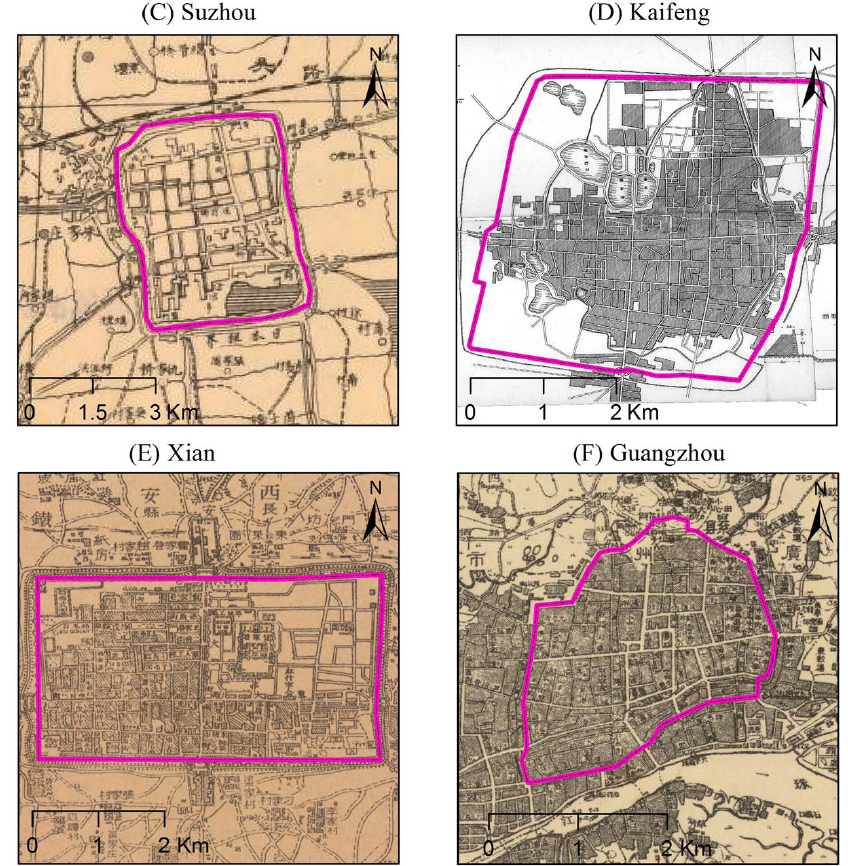
Figure 1. Example of the urban scope marks in the military topography of the Republic of China ( A − F represent Beijing, Nanjing, Suzhou, Kaifeng, Xian, and Guangzhou,